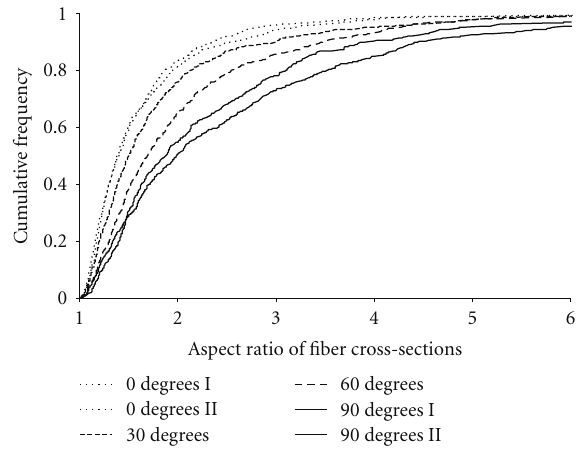
Figure 6: Cumulative frequency distributions of fiber aspect ratios. The inserted drawing shows the correlation between the cross- sectional angles and the flow direction of the fibers in the injection molded tensile specimens.